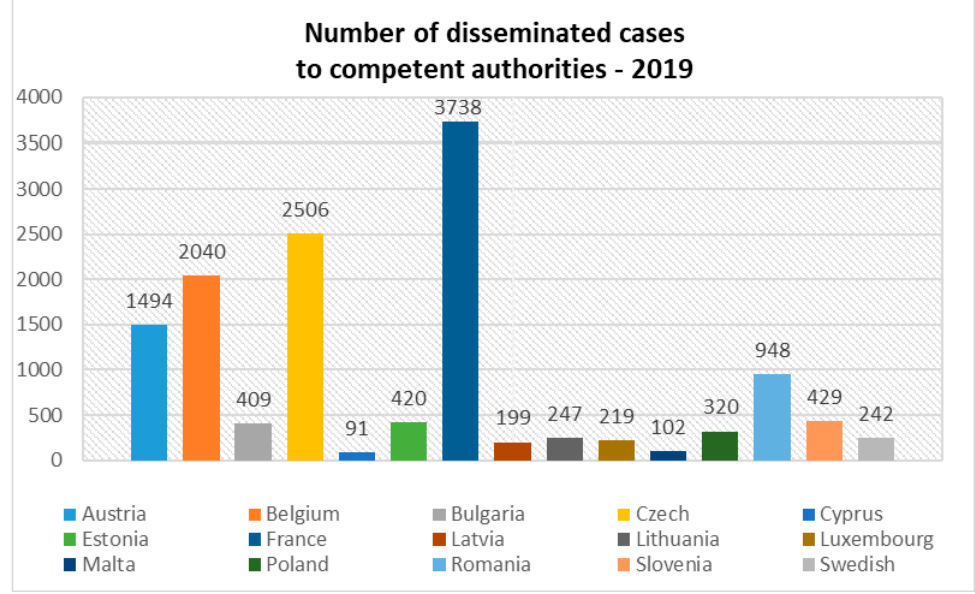
Figure 4. Number of FIU disseminated cases to competent authorities in 2019. Source: own processing. Table 2. FIUs with more of seven thousand reports disseminated in 2019. Country